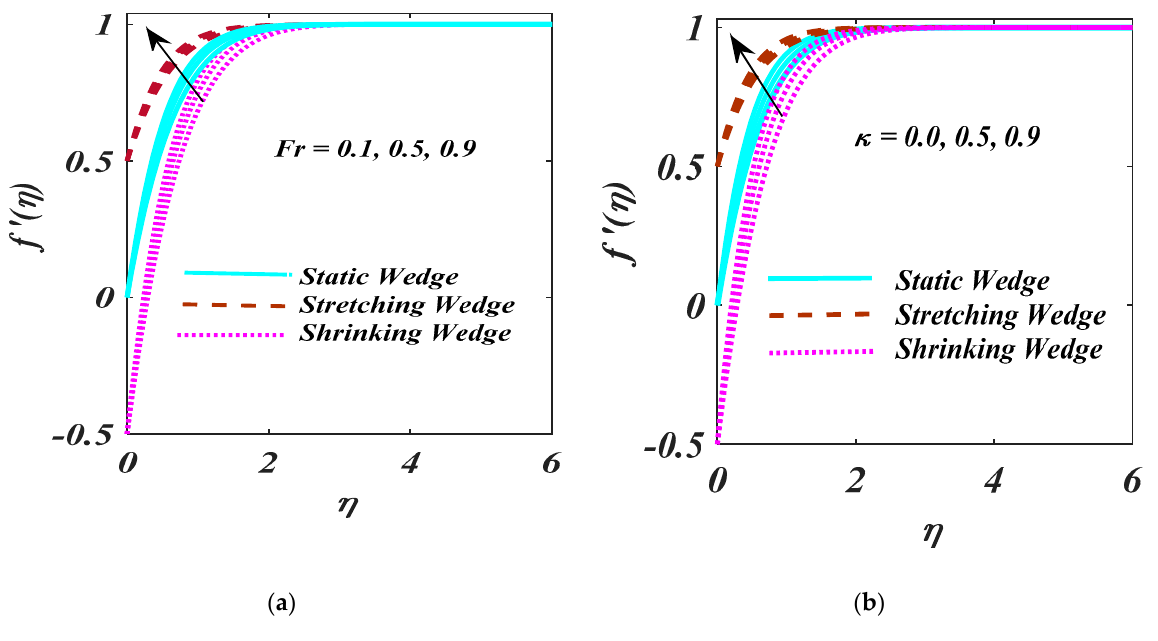
Figure 3. ( a , b ) f (cid:48) ( η ) impacton Fr and κ The characteristics of (cid:1839) on the (cid:1858) (cid:4593) (cid:4666)(cid:2015)(cid:4667) , (cid:1840)(cid:4666)(cid:2015)(cid:4667) (cid:2016)(cid:4666)(cid:2015)(cid:4667) , (cid:2038)(cid:4666)(cid:2015)(cid:4667) is demonstrated in Figure